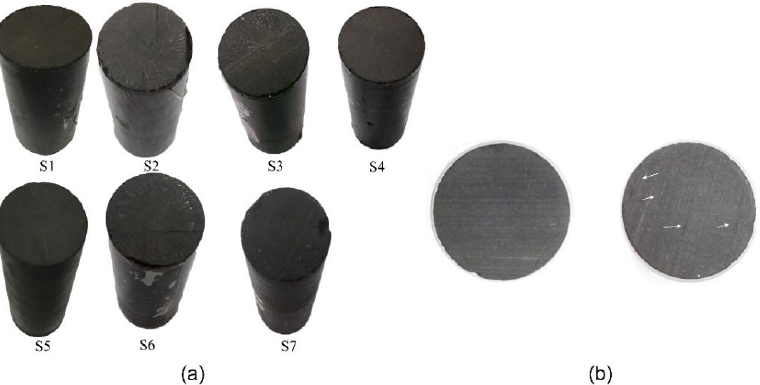
Figure 3. Experimental samples ( a ) and their exact position in the core sample ( b ). Table 1. Basic parameters of shale samples.